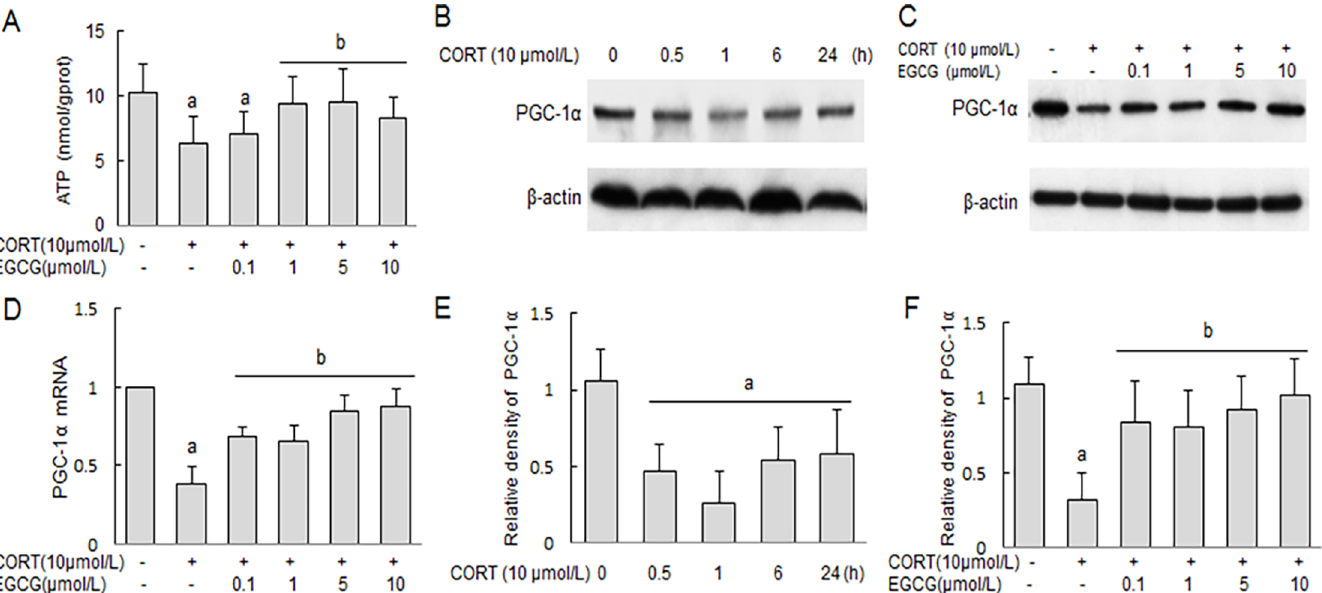
Fig 8. Effect of EGCG on CORT-induced changes of ATP and PGC-1 α expressions in primary hippocampal neurons. Primary hippocampal neuron cultures were stimulated with CORT for indicated time period in the absence of presence of EGCG pretreatment (for 2 h) at indicated concentrations. The cultured hippocampal neurons were harvested and lysed to measure cellular ATP content, as well as PGC-1 α protein and mRNA expression. The PGC-1 α protein content was measured by western blot analysis, whereas the PGC-1 α mRNA levels were determined by RT-PCR and expressed as mean ± SD of GAPDH mRNA level. A) The production of ATP; B, C) Examination of PGC-1 α by western blot; D) The expression of PGC-1 α mRNA; E, F) The relative expression of PGC-1 α . a P < 0.05 vs normal control group: b P < 0.05 vs CORT treatment